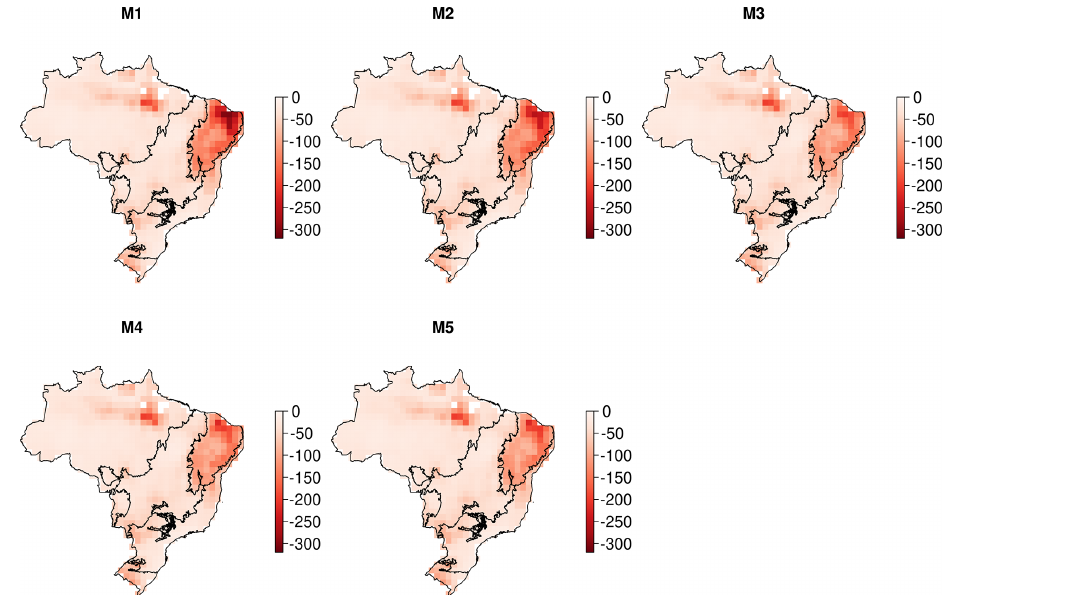
Figure A4. Maps showing the pixel-level median log-likelihood scores achieved by each. More negative values indicate a greater disagree- ment between the model-simulated carbon cycle and corresponding observational constraints. The Brazil-wide averaged likelihood scores are − 48.7, − 47.7, − 45.1, − 45.6 and − 45.7 for models M1–5,